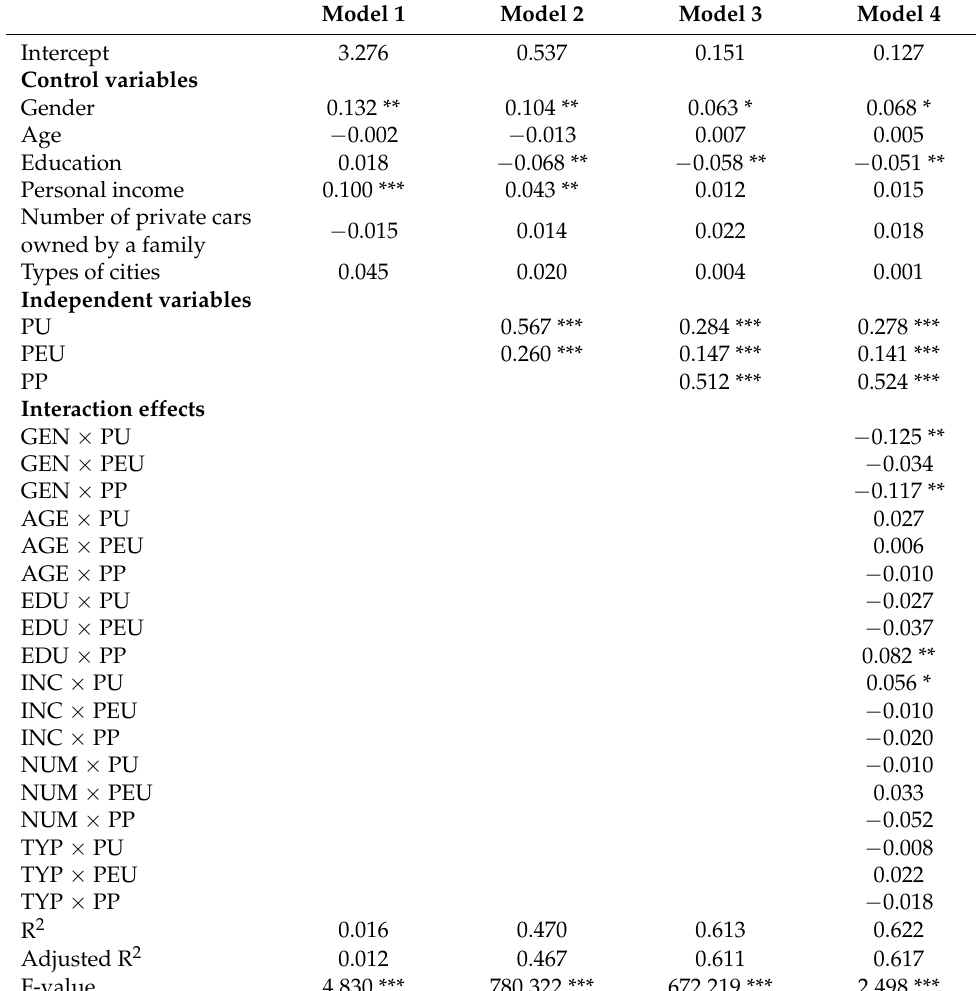
Table 4. Impacts of psychological factors and moderating effects of demographic